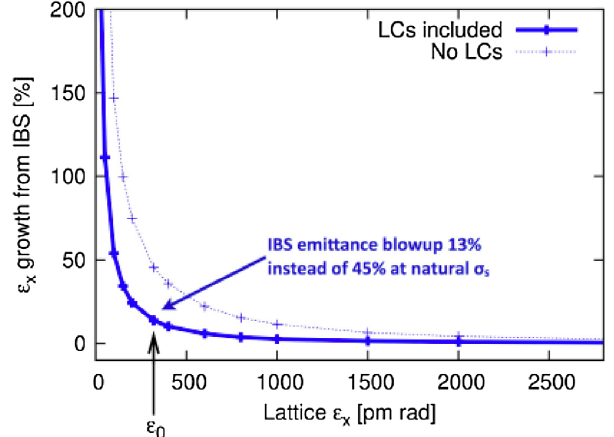
FIG. 7. % Horizontal beam emittance growth due to intrabeam scattering LCs ¼ Landau cavities, ð ε E ¼ 3 GeV; I ¼ 500 mA; δ